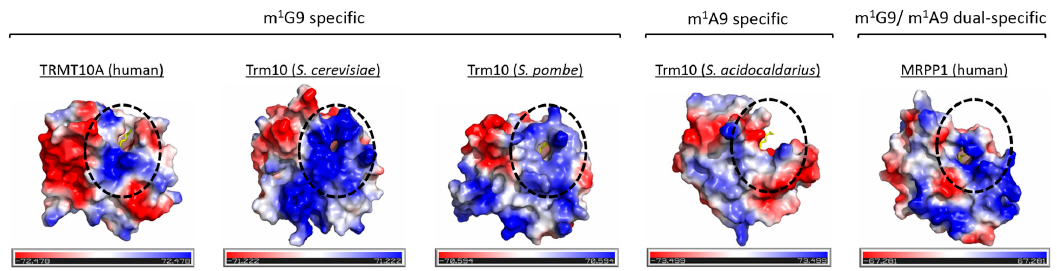
Figure 7. The electrostatic potential of the SPOUT domain for each Trm10 member for which a crystal structure is available. The SAM cofactor is shown as yellow sticks. The N1-methylation specificity is shown for each Trm10 member.